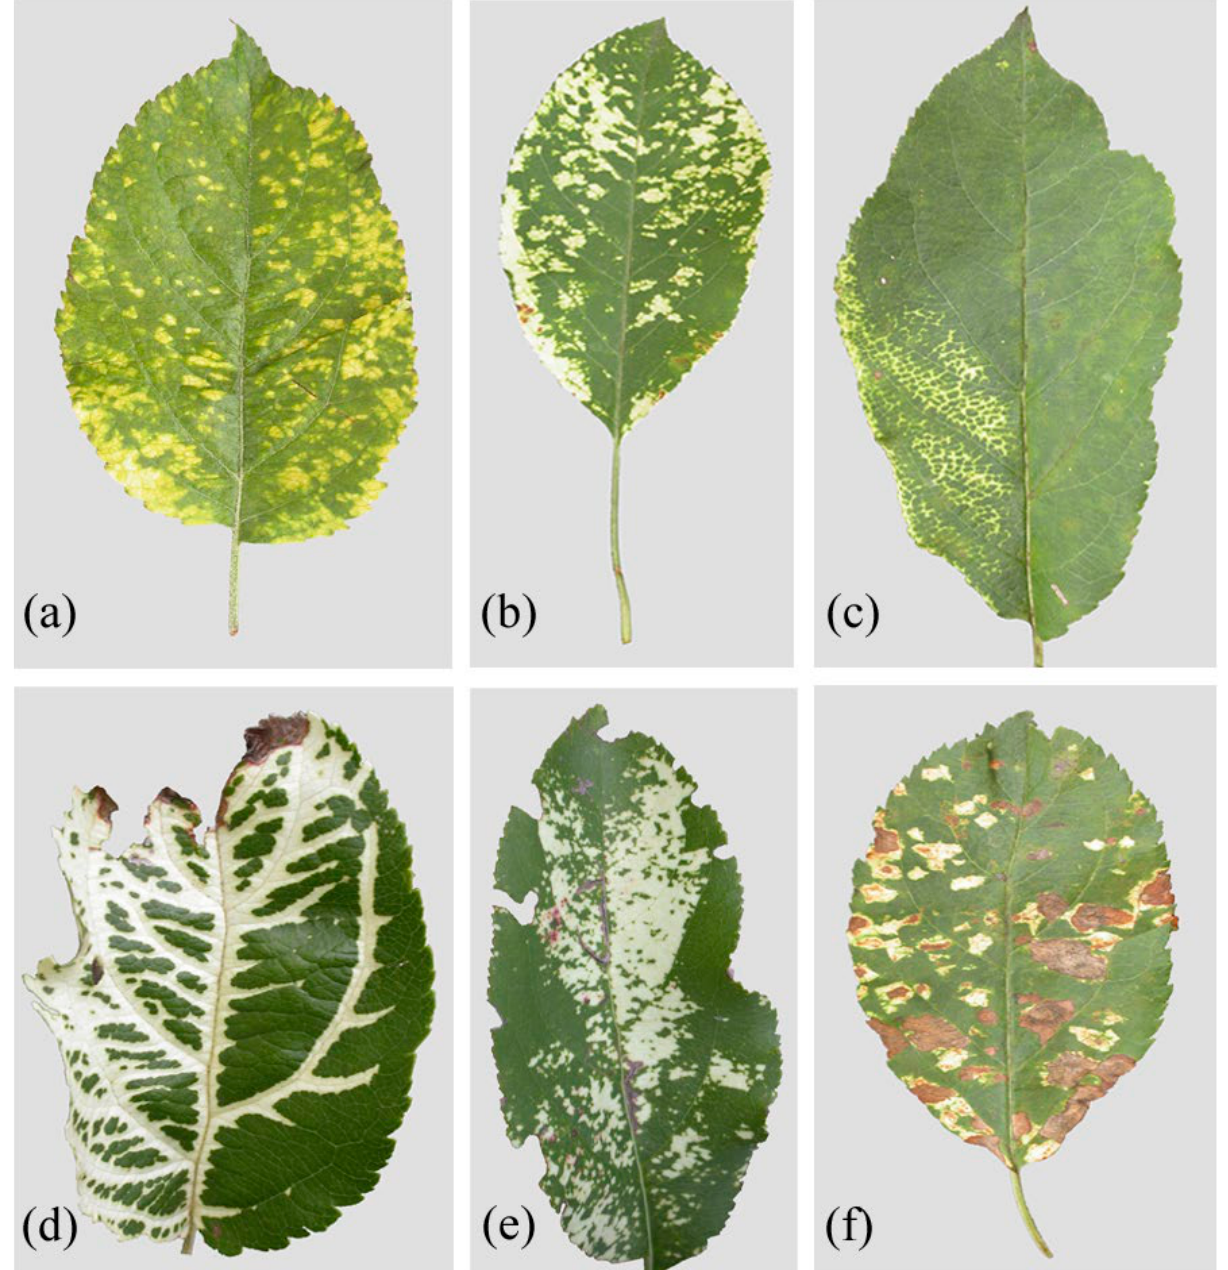
Figure 1. Symptoms associated with infection by ApMV in the form of line patterns and/or rings on apple